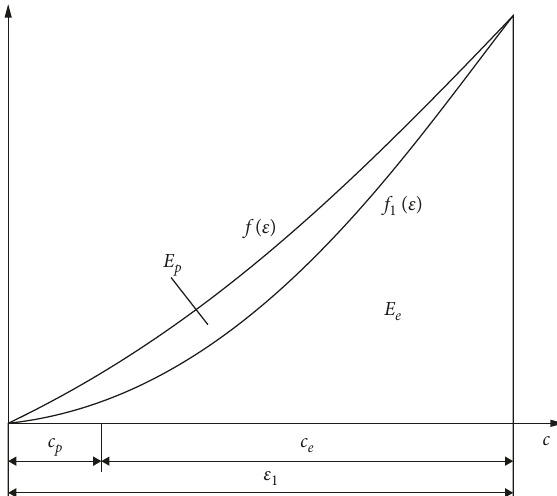
Figure 3: Elastic deformation energy index curve.